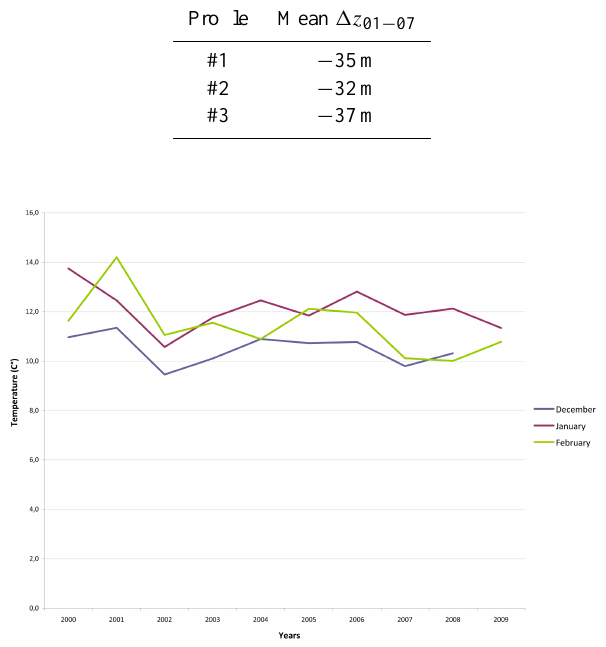
Table 1. Mean ice elevation change 2001–2007 of Las Vacas Glacier along selected flow lines according to Fig.